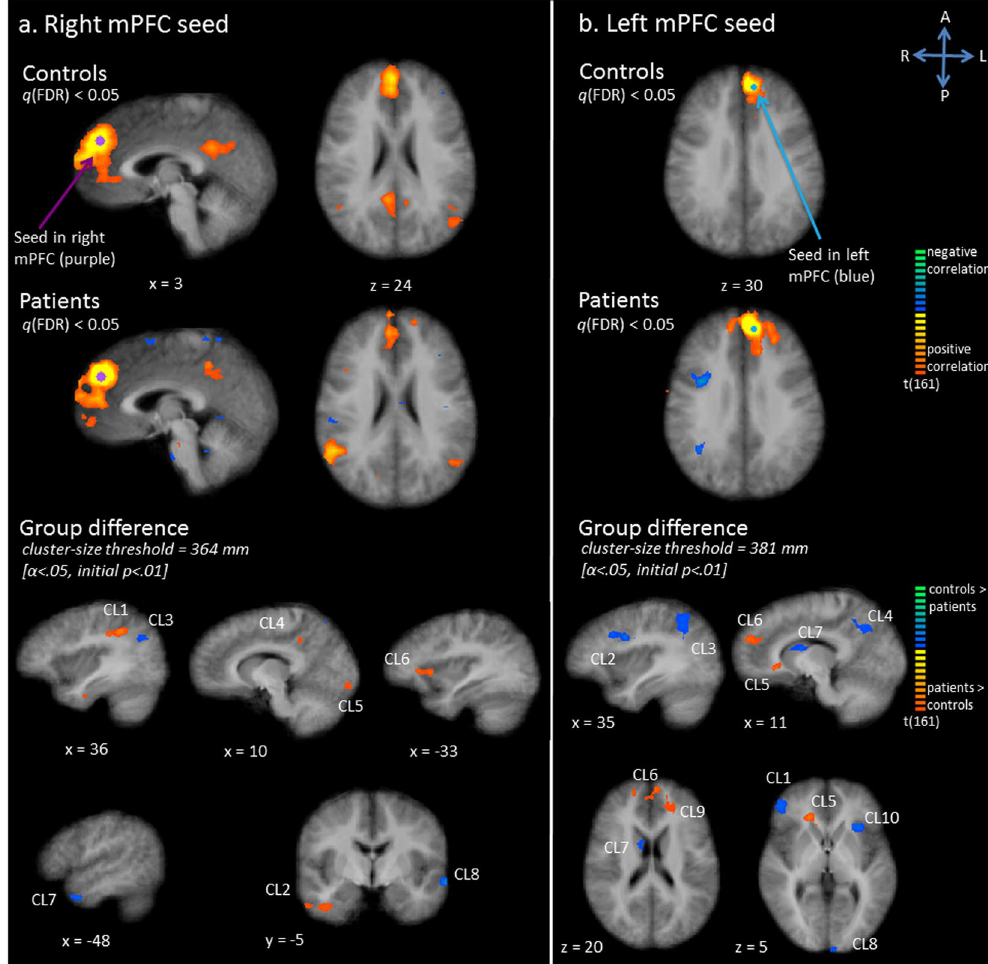
Figure 1. Functional connectivity (Fc) maps for the medial prefrontal cortex (mPFC) as seed; panel a: right mPFC seed, panel b: left mPFC seed. Upper and middle row: Statistical maps resulting from the seed- based correlation analysis separate per group (red indicates positive correlation, blue indicates negative correlation). Seeds are overlaid in purple (right mPFC seed) or blue (left mPFC seed). Maps are thresholded at q (FDR) < 0.05. Lower row: Group differences in functional connectivity per seed region (red indicates patients show increased connectivity as compared to controls, blue indicates patients show decreased connectivity as compared to